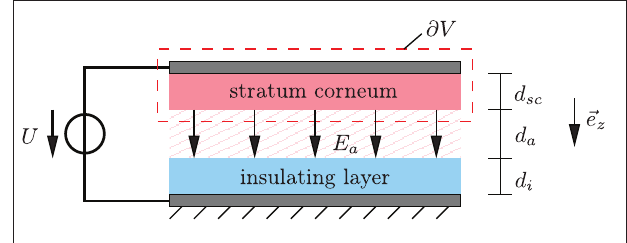
FIGURE 2 | Parallel-plate capacitor model; the dashed line marks the integration domain used for calculation of the electrostatic force.